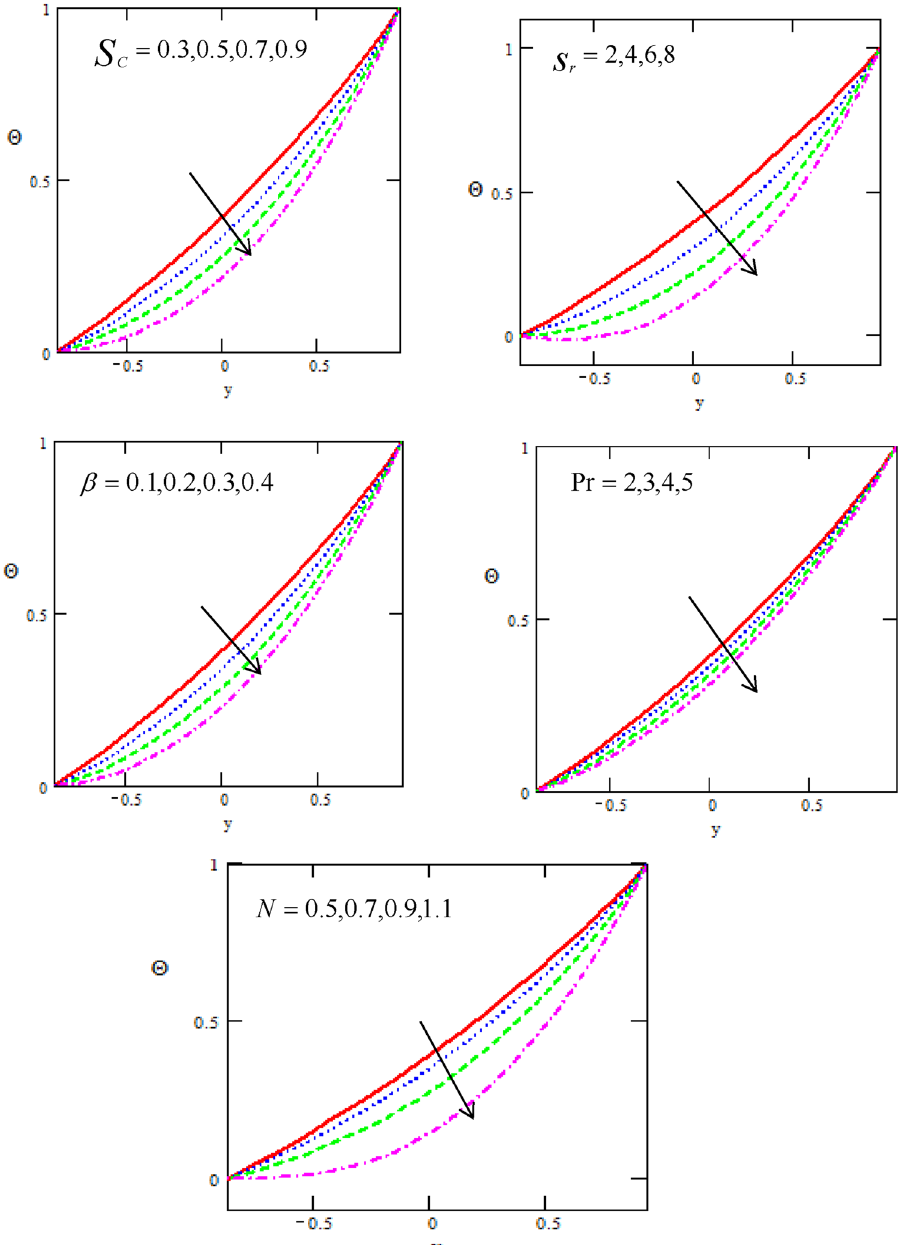
Figure 4. Variation of the Concentration (cid:31) concerning the axial-y with different values of Sc , Sr , β , Pr, N